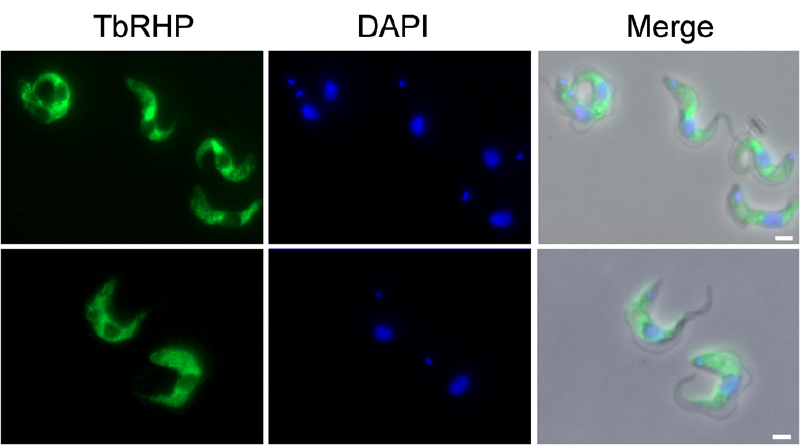
Figure 2. TbRHP is a cytosolic protein. BSF trypanosome cells expressing HA-TbRHP were prepared for immunofluorescence using a murine monoclonal anti-HA antibody followed by goat anti-mouse IgG FITC conjugate (green). DAPI was used to visualize DNA (blue). Left panels are HA fluorescence, middle panels DAPI and right merge with the phase contrast image. Bars, 2 m m.